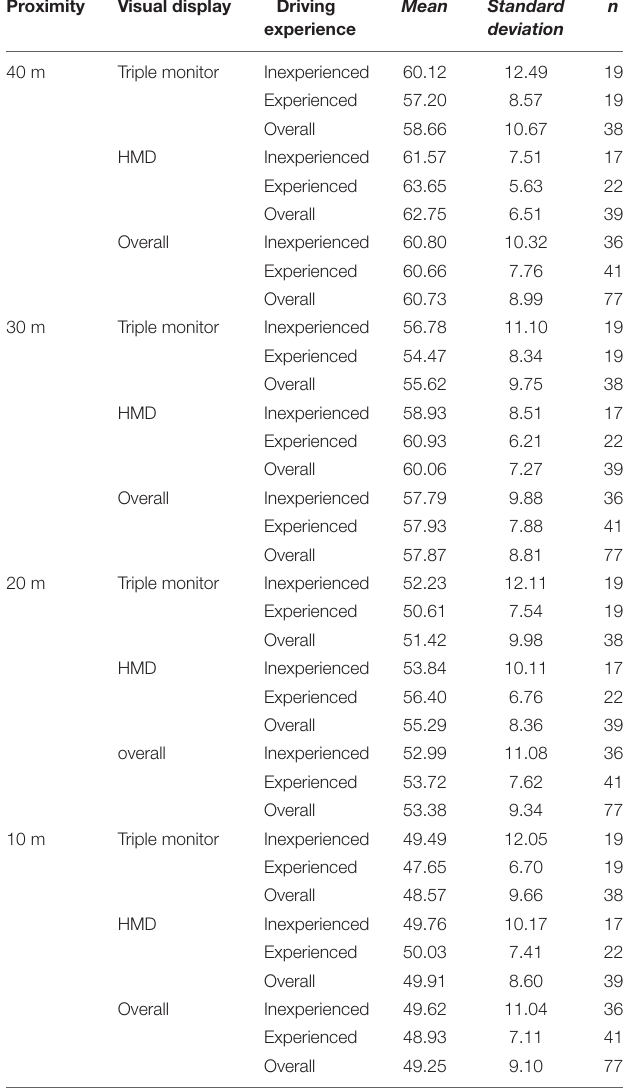
TABLE 3 | Descriptive data for driving speed at the four way points for the two display devices and driver groups. Proximity Visual display